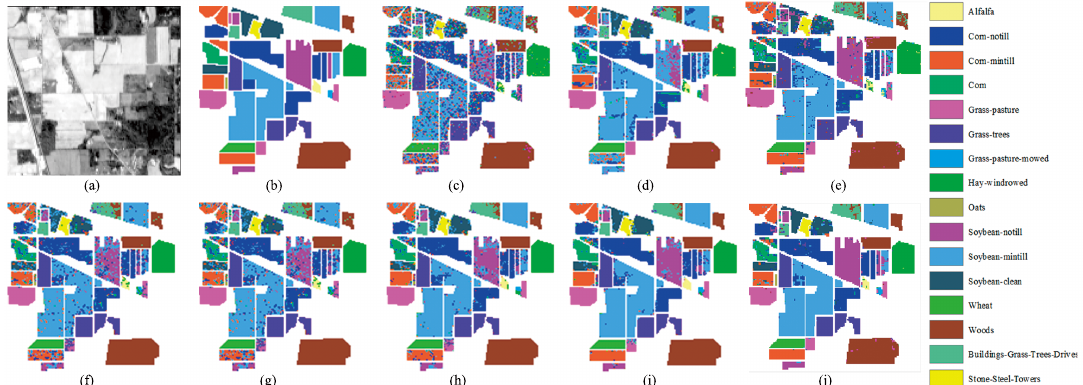
Figure 9. Classification results obtained by different classifiers for the AVIRIS Indian Pines scene. ( a ) Original map; ( b ) Reference map; ( c ) Spe s classification map; ( d ) EMAP s classification map; ( e ) Deep s classification map; ( f ) Spe o classification map; ( g ) EMAP o classification map; ( h ) Nonlocal weighting sparse representation (NLW-SR) classification map; ( i ) Spectral-spatial deep convolutional neural network (SSDCNN) classification map; ( j ) Deep o classification map.